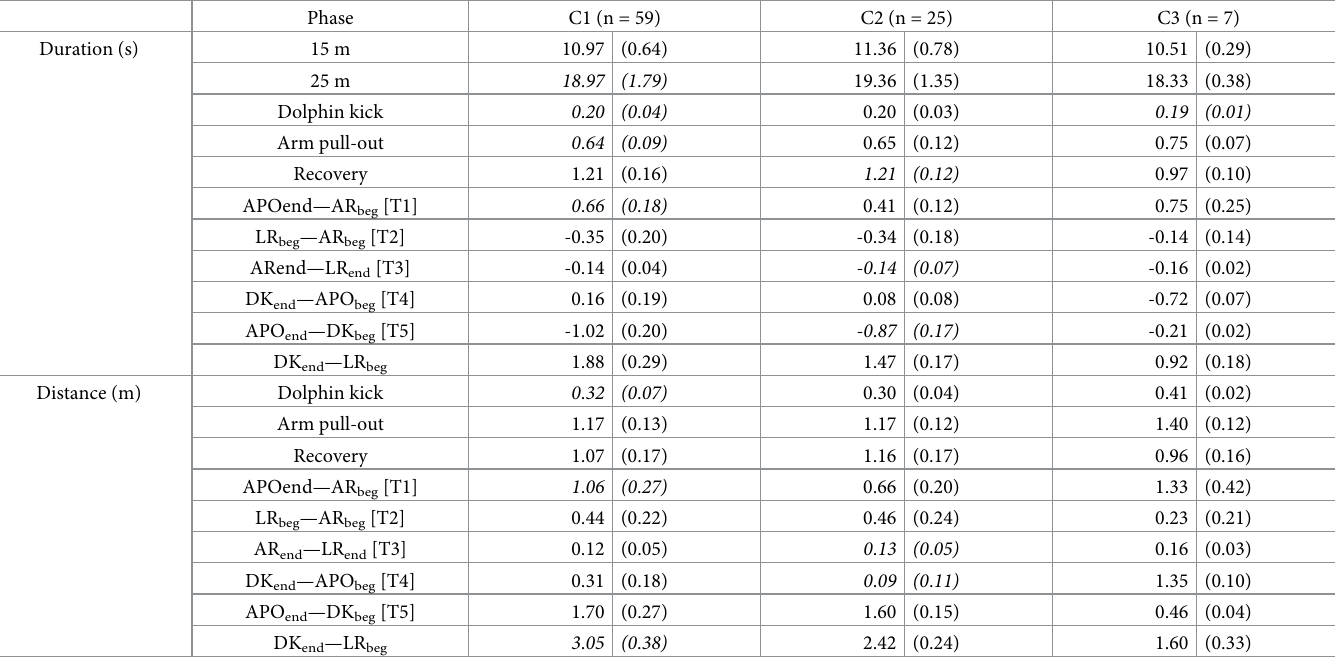
Table 2. Mean (SD) of 15 m time, 25 m time, and absolute time and displacement of the active underwater phases in each